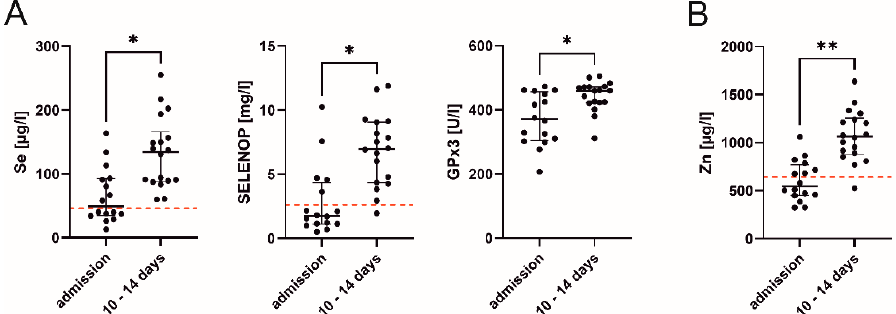
Figure 2. Supplementation increased the ( A ) selenium (Se) status biomarkers and ( B ) zinc (Zn) levels over the course of intensive care. Each black dot represents an individual patient. The lower end of each reference range is indicated by a red dashed line. Ranges were adopted from the European Prospective Investigation into Cancer and Nutrition (EPIC) study. However, glutathione peroxidase 3 (GPx3) levels have not been determined in a large patient collective so far. Therefore, a validated